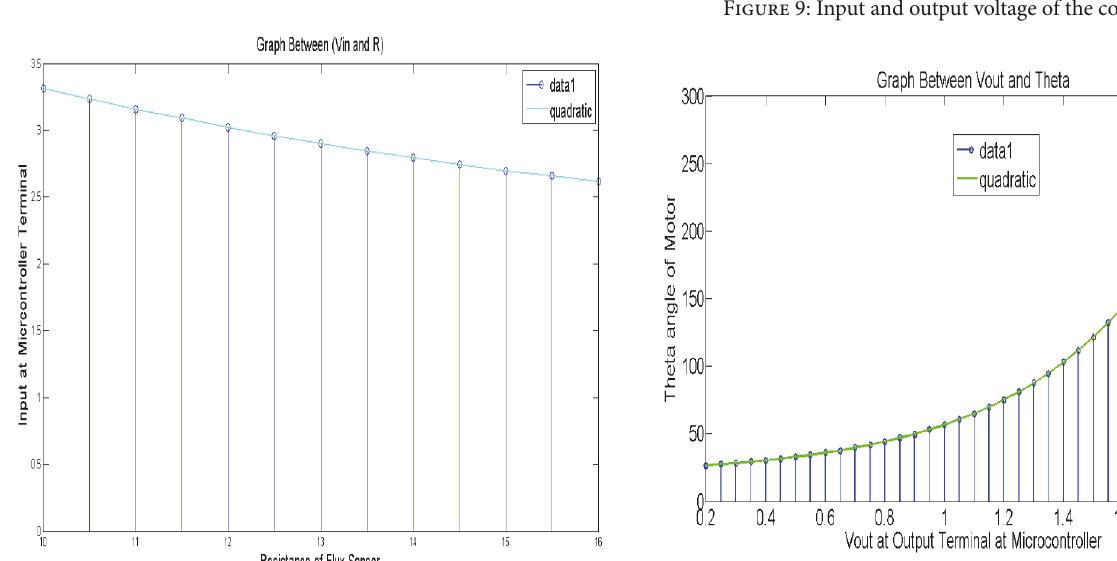
Figure 10: V(out) versus speed of the